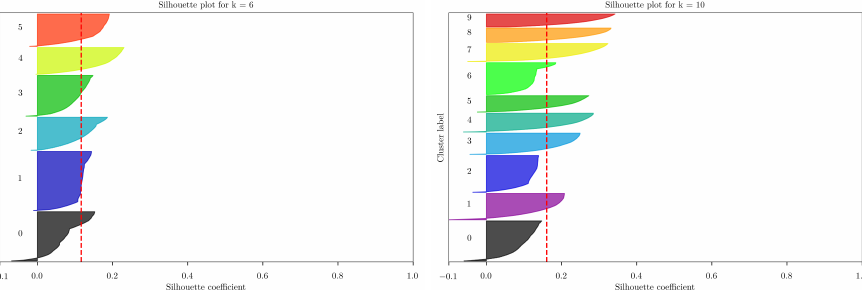
Figure 27. Silhouette plot for k = 6 ( left ) and k = 10 ( right ) for the hierarchical agglomerative clustering